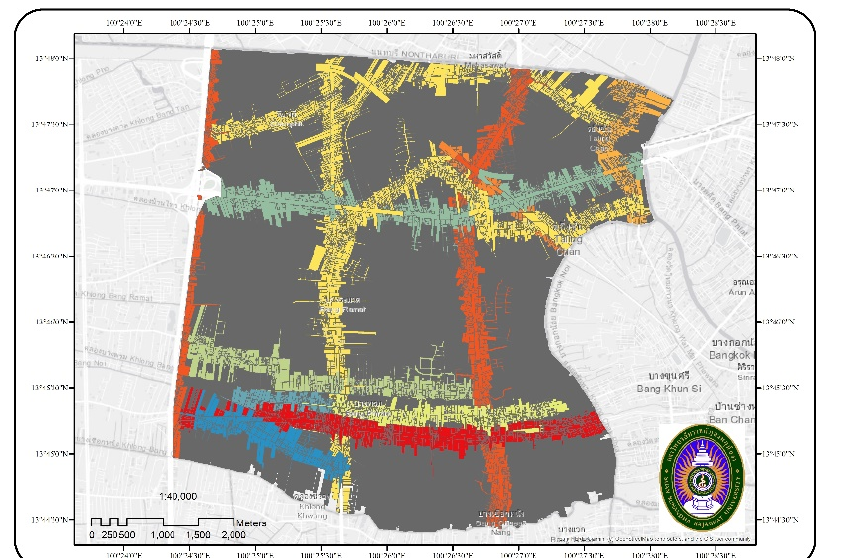
Figure 4. The study area consisting of 45,032 land parcels selected from all over the Talingchan district as the experimental data. Descriptive statistics of the independent variables of the Talingchan district, Bangkok are given in Table 1 and show the number of points-of-interest in the study area. The table includes the number of points in the POI datasets, from school to grocery store, in point units. Descriptive statistics of the independent variables are shown in Table 1. Table 1. Independent